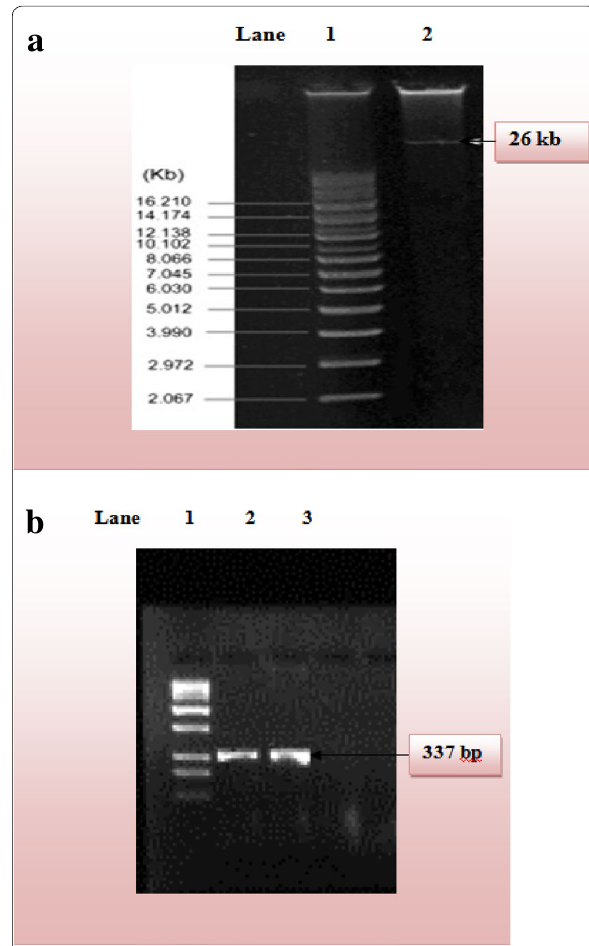
Fig. 5 a Genomic characterization of potential microorganism responsible for bioremediation Anthracene. Plasmid DNA isolated from potential microorganism, Pseudomonas aeruginosa. Lane 1 DNA ladder, Lane 2 26 kb plasmid. b Agarose gel of PCR products. Lane 1 (from left ) 1-kb ladder, lane 2 337-bp DNA fragment generated from P. putida NCIB 9816-4 which was taken as positive control, and lane 3 337-bp DNA fragment generated from potential microorganism